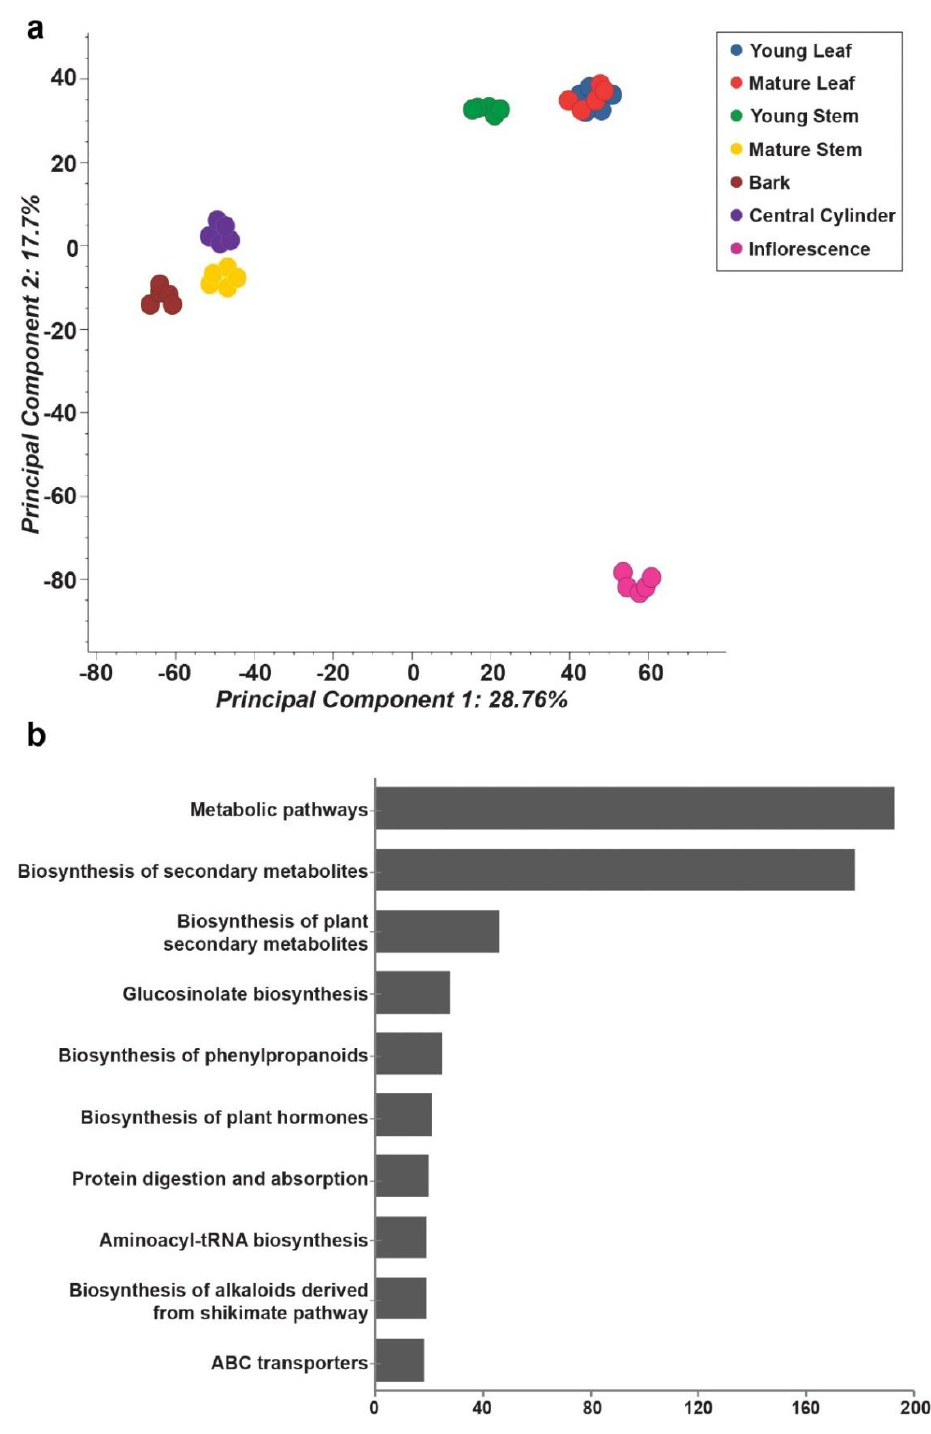
Figure 2. Untargeted metabolome analysis for seven tissues of Mallotus japonicus . ( a ) Principal component analysis using the metabolome datasets acquired for seven tissues of M. japonicus ; ( b ) The top 10 KEGG pathways based on the number of metabolites assigned. The chemical identities of the mass features and corresponding KEGG compound ID were assigned based on a narrow mass-error window of 10 ppm, and candidate metabolites were grouped according to the assigned KEGG pathway